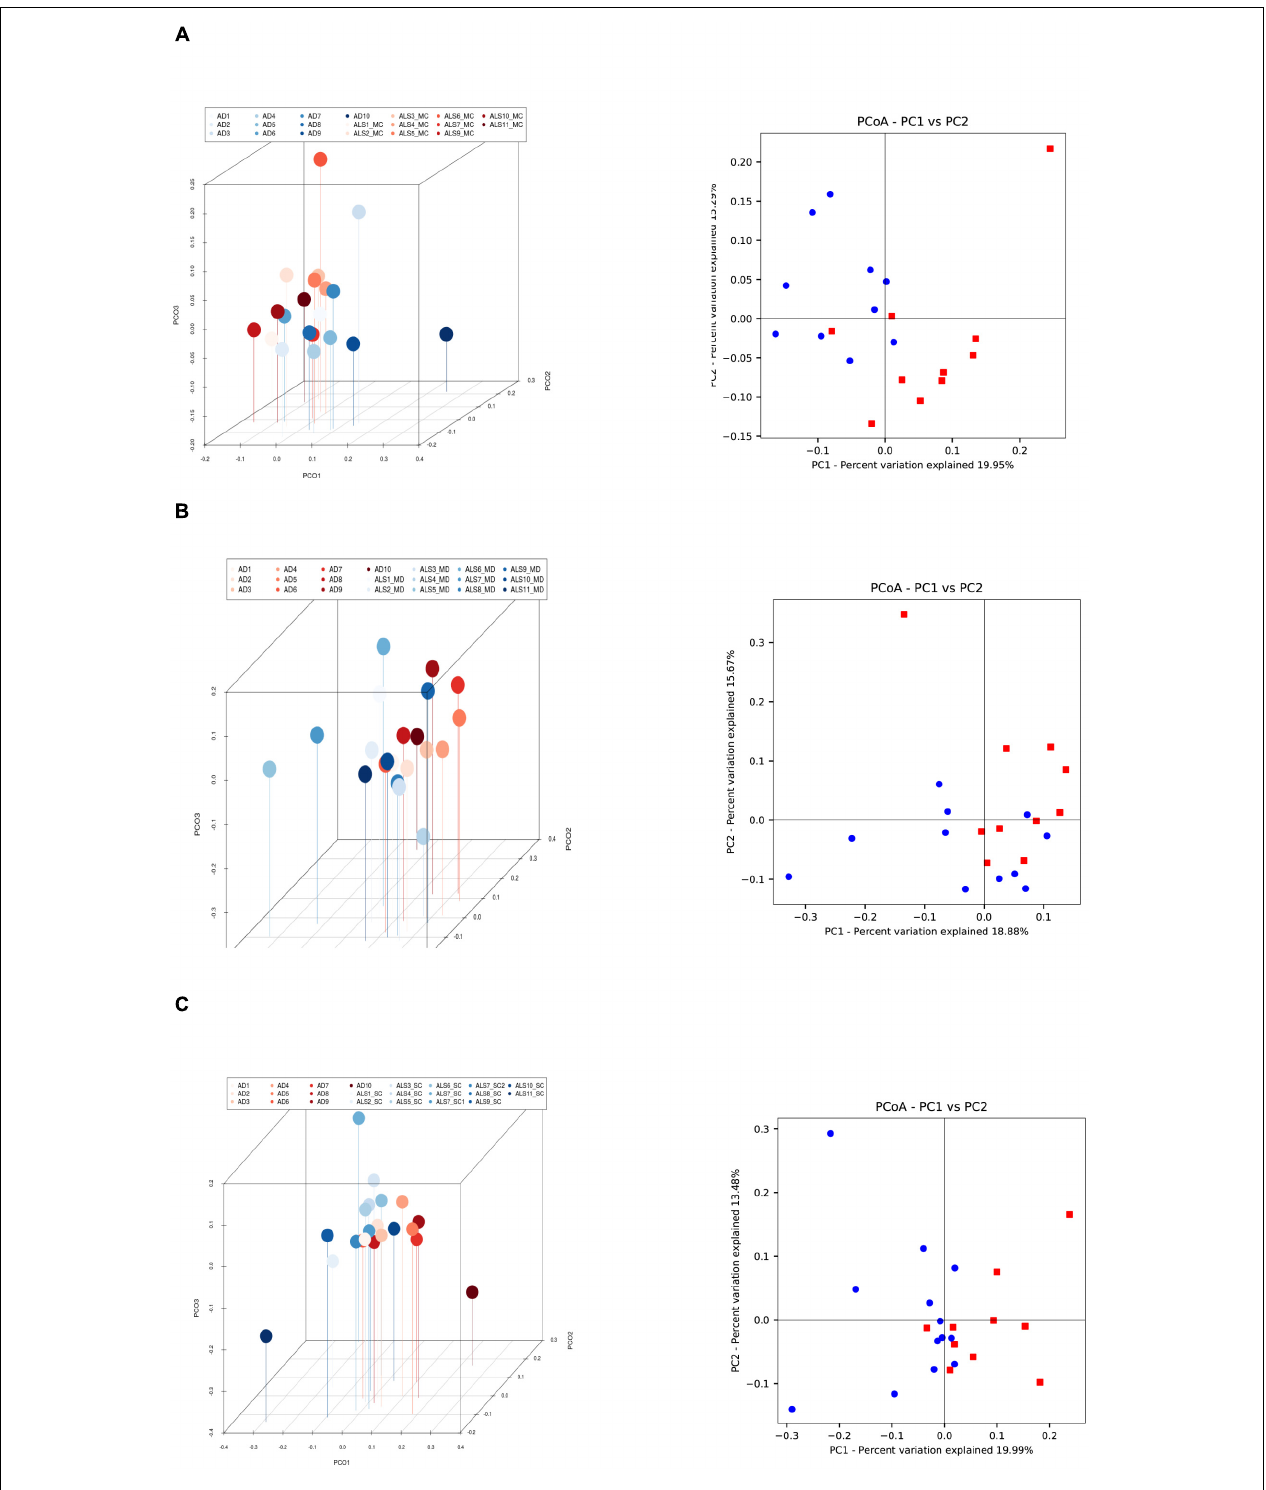
FIGURE 4 | Three- and two-dimensional principal component analysis of bacteria of CNS regions from ALS patients and AD patients. Comparison of three separate CNS regions between AD and ALS patients. (A) Left panel: three-dimensional (3D) principal component analysis (PCA) between MC regions of ten ALS patients (plots in red) and 10 AD patients (plots in blue). Right panel: 2D PCA. (B) Left panel: 3D PCA between MD regions of eleven ALS patients (plots in blue) and ten AD patients (plots in red). Right panel: 2D PCA. (C) Left panel: 3D PCA between SC regions of 11 ALS patients (plots in blue) and 10 AD patients (plots in red). Right panel: 2D PCA. The UniFrac method was used to calculate this parameter. MC, motor cortex; MD, medulla; SC, spinal cord.